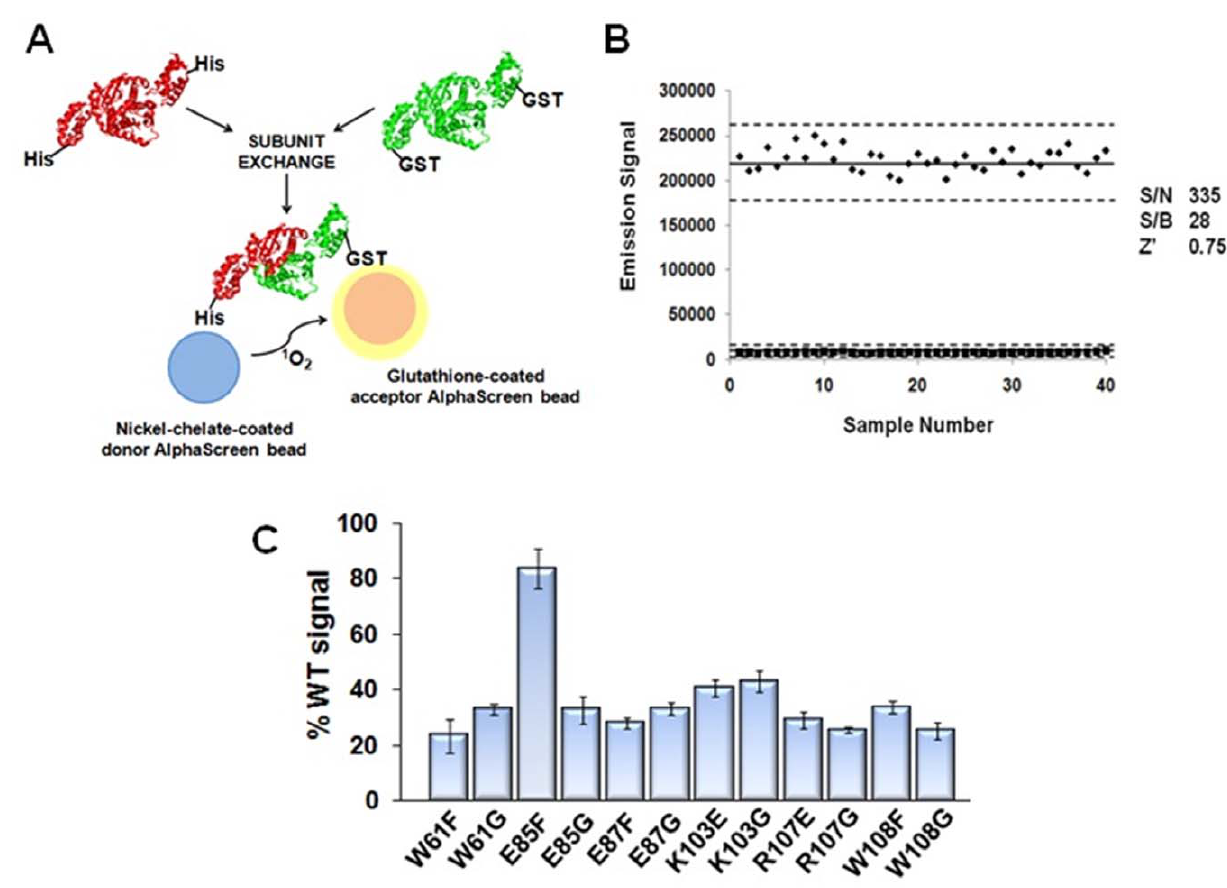
Figure 6. A quantitative IN subunit exchange assay specifically illustrates multimerization defect of IN dimeric interface mutants. (A) Mechanics of the subunit exchange assay for quantifying HIV-1 IN multimerization. Mutant IN was expressed with a 6x Histidine tag, while WT IN was expressed with a GST tag. Mutant IN proteins with functional oligomerization were capable of carrying out subunit exchange with WT IN, resulting in a hybrid subunit protein containing each tag. Subunit assembly allowed energy transfer between donor and acceptor beads and emission of luminescence. (B) Z-factor calculation for AlphaScreen-based multimerization assay – reproducibility of the assay deemed ‘‘excellent’’ with score of 0.75. Signal-to-noise and signal-to-background ratios are optimally high, at 335 and 28, respectively. Solid lines denote mean of positive control and background signal, and dotted lines represent three standard deviations from each data set. (C) Application of the multimerization assay to the measurement of mutant IN multimerization, relative to that of the WT protein. Catalytically inactive IN mutant proteins exhibited around 20– 30% of WT multimerization capacity, but only the catalytically active E85F mutant protein approached WT levels of multimerization.